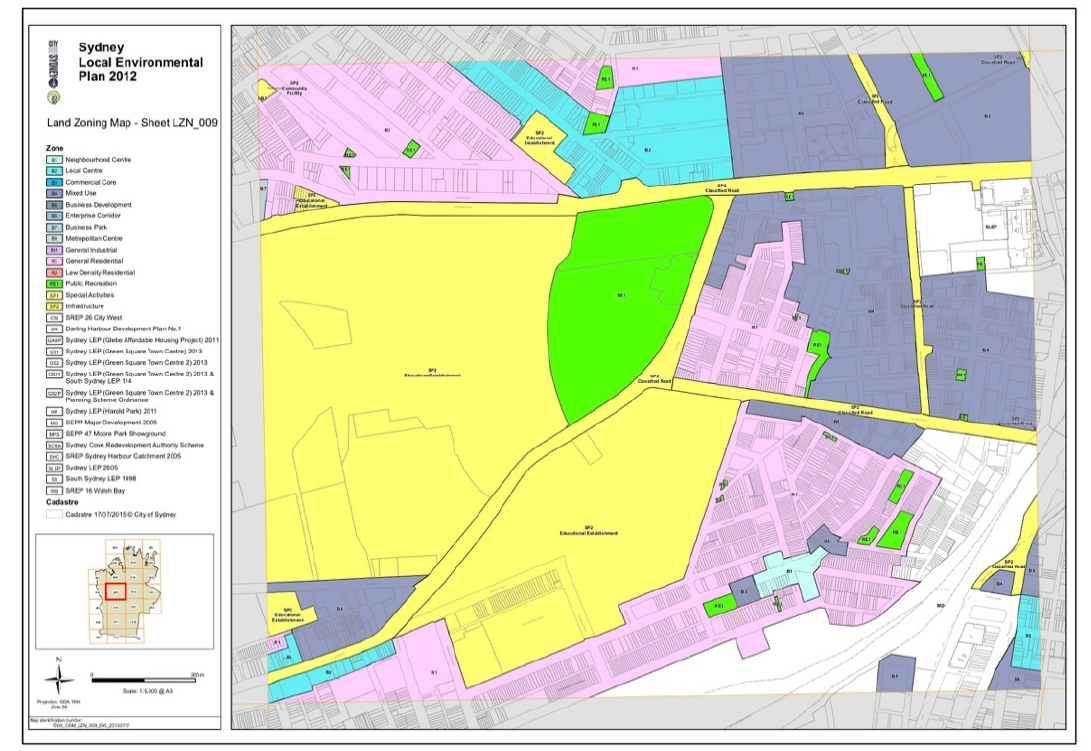
Figure A4. Chippendale Land Zoning Map LEP. Macquarie Park [25]